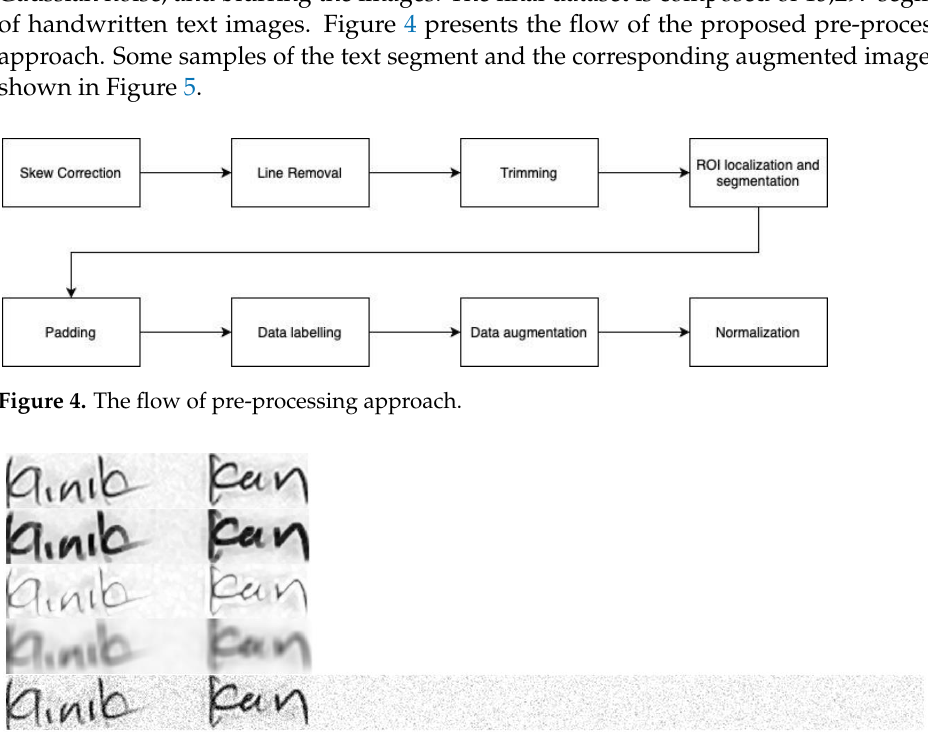
Figure 3. Sample labeled image.